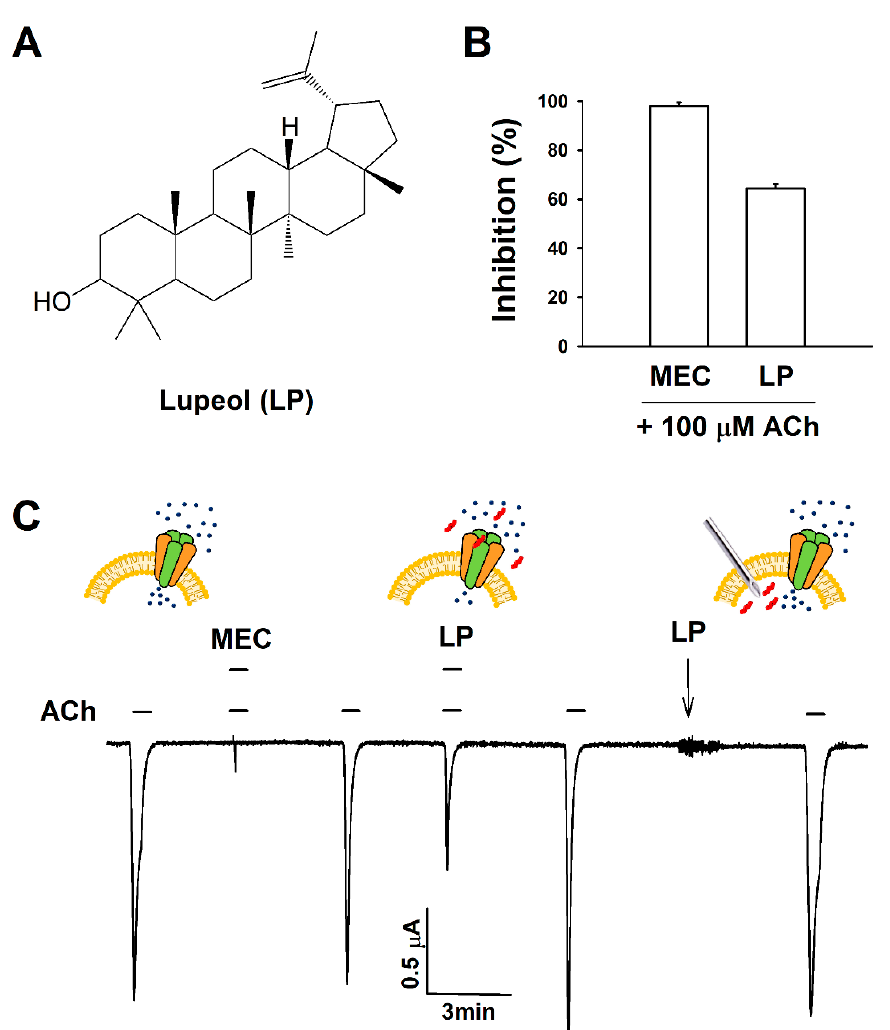
Figure 1. Structure and regulatory effects of lupeol on the α 3 β 4 nicotinic acetylcholine receptors. ( A ) Chemical structure of lupeol (LP). ( B ) Summary of inhibitory effects of cotreatment of lupeol with acetylcholine. ( C ) Typically, 100 μ M acetylcholine was applied with or without 30 μ M lupeol. Mecamylamine (MEC) is an antagonist of nicotinic acetylcholine receptors (nAChRs). MEC shown at concentration of 10 μ M. Arrow, point were LP was not treated onto oocyte surface but injected into cells. Traces representative of 5–9 separate oocytes from 3–5 different frogs. I Ach recorded at holding potential of − 80 mV before lupeol treatment. Small blue circle, cation; red one, lupeol.